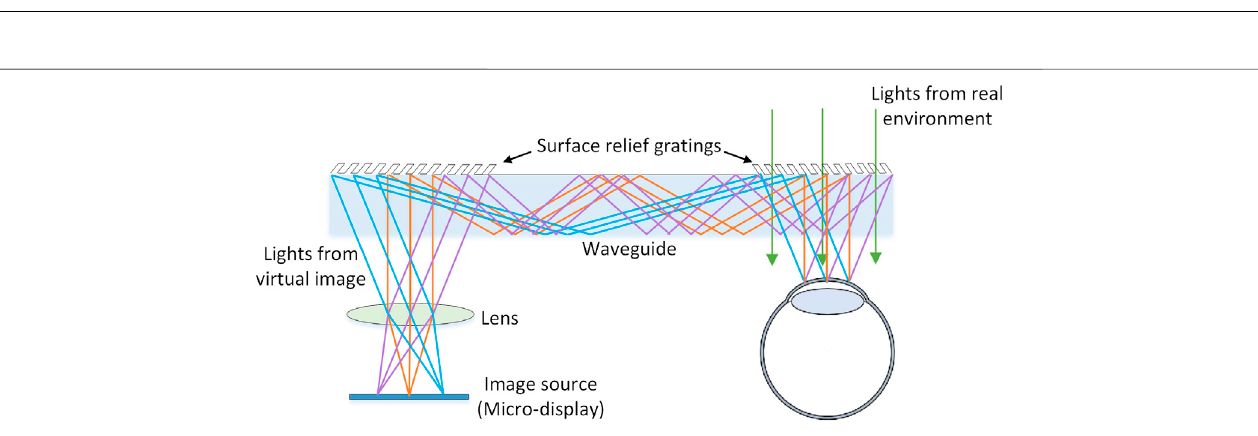
FIGURE 3 | Diagram of diffractive waveguide based AR NED. The in-coupler with slanted gratings in-couples the collimated light to enter the waveguide at a particular angle and then the light travels through the waveguide to the other end with an out-coupler. The out-coupler will out-couple the light from the waveguide via diffraction and project the light into the viewer ’ s eye at a certain